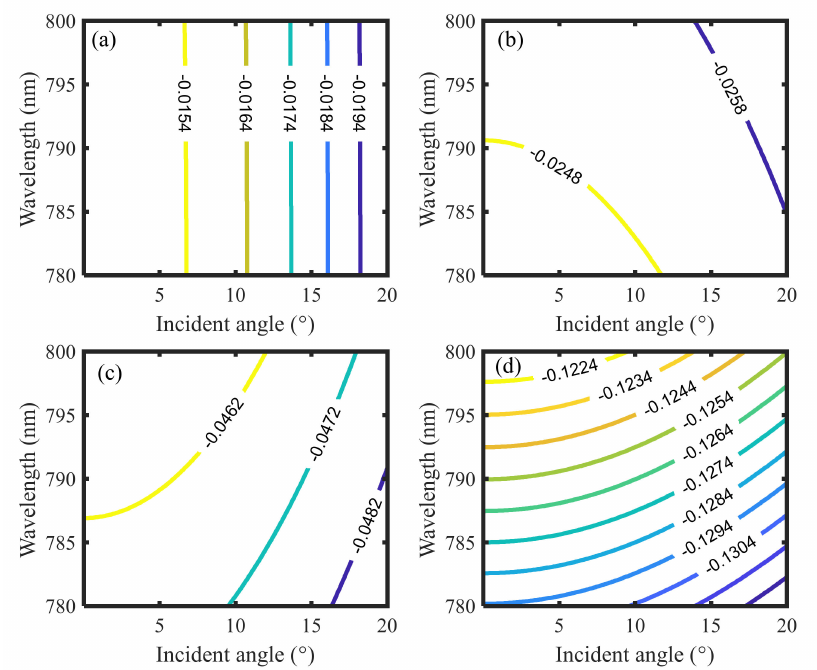
Figure 13. The contour map of ∆ n of the investigated materials. ( a ) BBO; ( b ) KDP; ( c ) LiNbO 3 ; ( d ) Ag 3 AsS 3 . In every subplot, the lines in different colors denote the different constants of ∆ n , and the step of ∆ n between different lines is